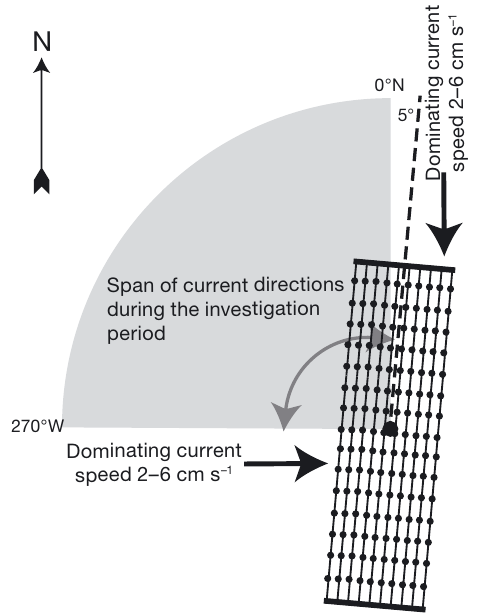
Fig. 2. Culture unit: 10 parallel longlines buoyed by floats (dots), each line 300 m long, and ca. 1.6 m between lines. Grey shaded area: the dominating current